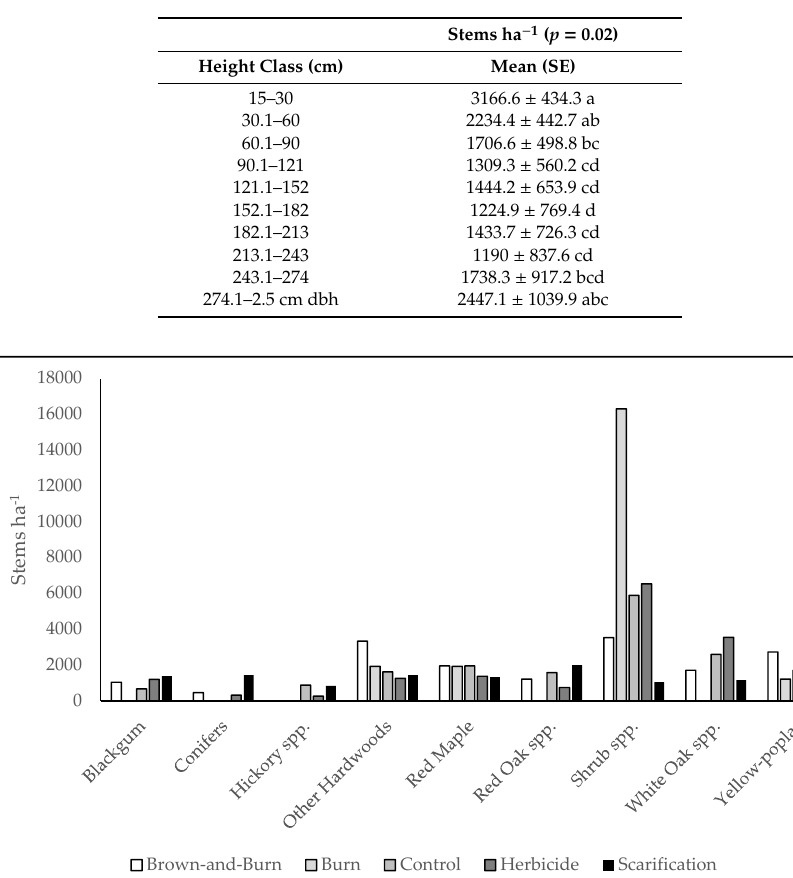
Table 5. Natural regeneration mean, standard error, and letter groupings for height class across all treatments are presented for inside cluster plantings for the five site preparation and release treatments tested in the shortleaf pine–hardwood establishment study, following four growing seasons in Morgan County, Tennessee, USA. Treatment means followed by the same letter in a column indicate no significant di ff erences ( p = 0.05).